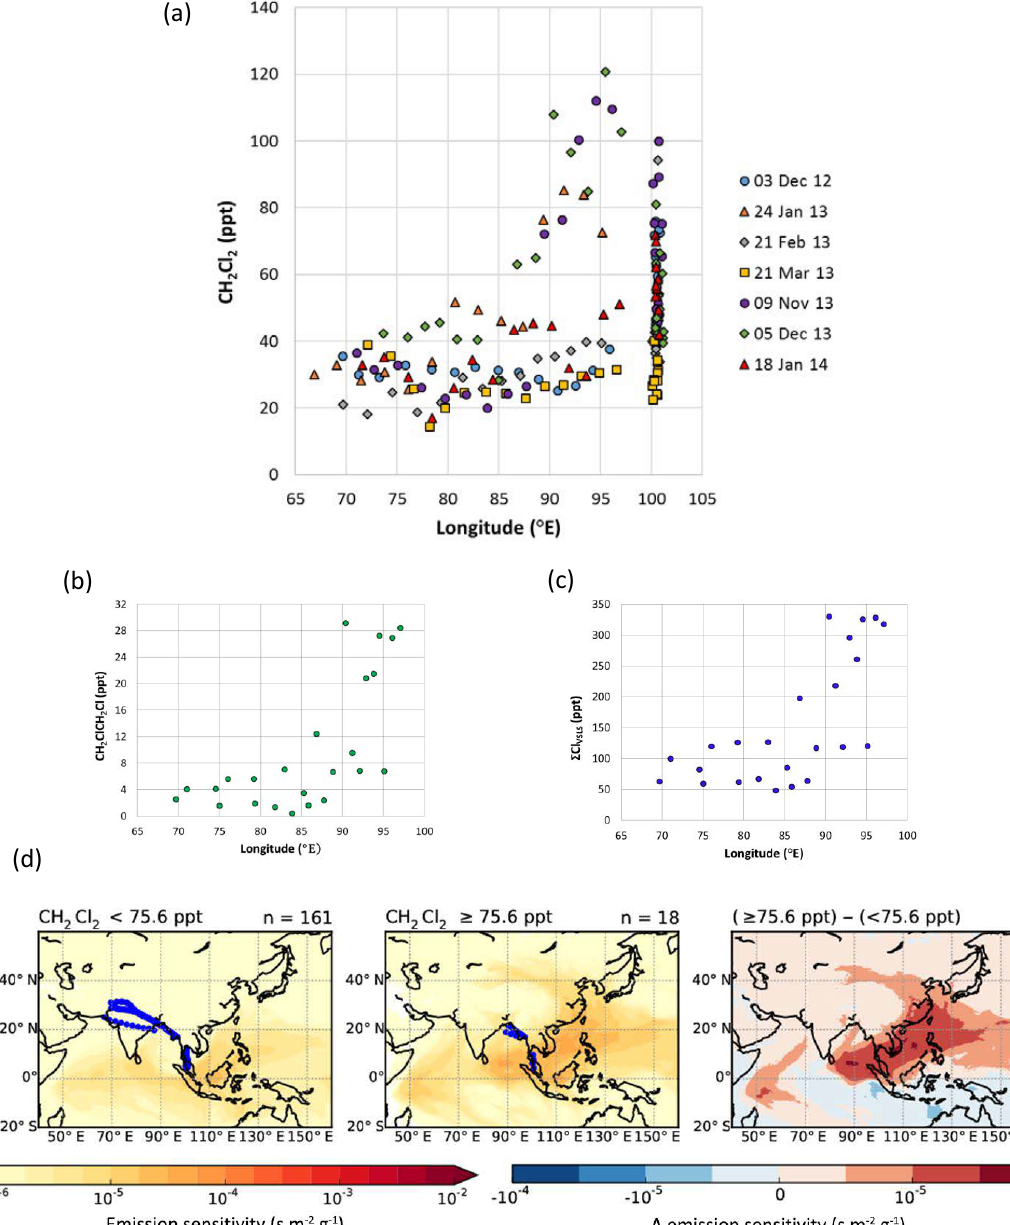
Figure 5. (a) Mole fractions (ppt) of CH 2 Cl 2 in CARIBIC air samples collected at 10–12km altitude over northern India, the Bay of Bengal, and SE Asia. The samples are plotted against longitude and have been coloured by date. (b) Mole fraction (ppt) of CH 2 ClCH 2 Cl in selected CARIBIC samples (note: CH 2 ClCH 2 Cl was not monitored in the samples collected between Bangkok and Kuala Lumpur and only in a selection of samples on the Frankfurt–Bangkok route). (c) Total Cl-VSLSs derived from the four compounds of interest in the CARIBIC samples (note: total Cl-VSLSs could only be calculated for the samples shown in b above). (d) NAME footprint maps indicating the likely origin of the air sampled by the CARIBIC aircraft. NAME footprints at this altitude, and particularly in regions of strong sub-grid-scale convection not captured fully in the gridded meteorological input data, may be less reliable than those at the surface sites. This makes pinpointing particular emission regions more difficult. The central panel therefore shows a composite footprint derived from the samples that contained the highest levels of CH 2 Cl 2 (90th percentile, [CH 2 Cl 2 ] > 75.6ppt), with the composite footprint from the remaining samples ([CH 2 Cl 2 ] < 75.6ppt) shown in the left-hand panel. To emphasise the likely source regions the right-hand panel shows the difference between the middle and left-hand panels. The geographical location of each sample included in the composite analysis is shown in blue